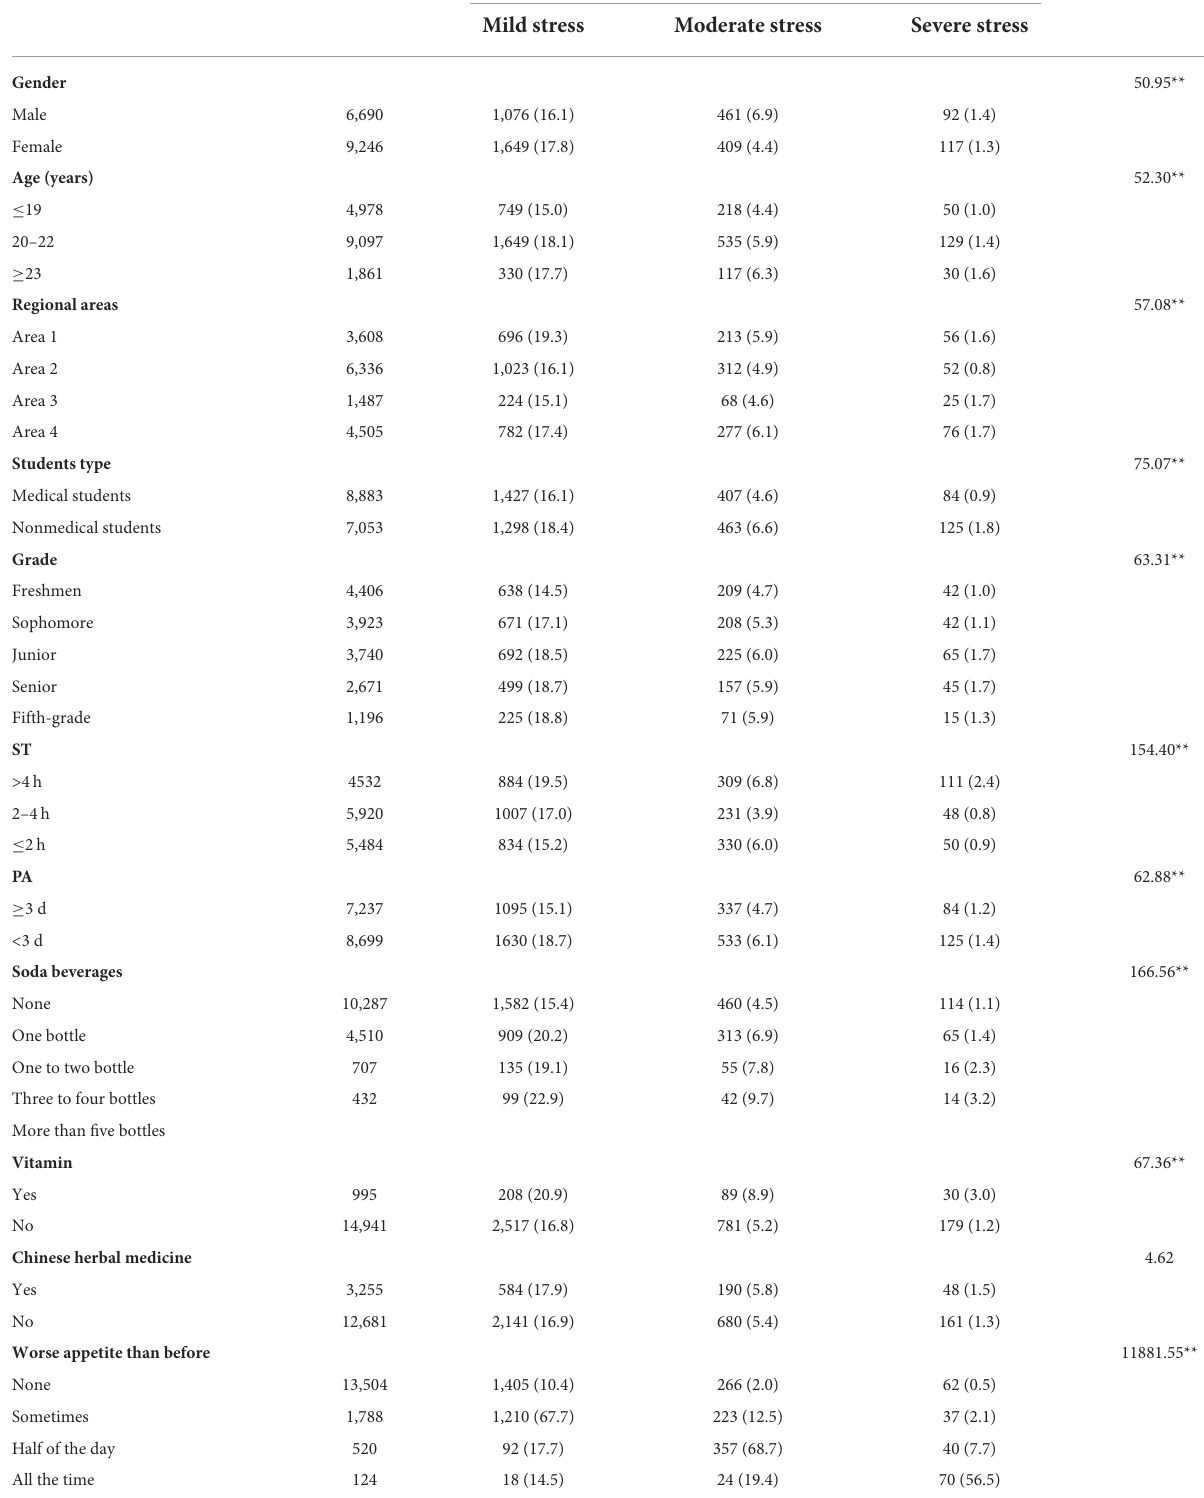
TABLE 2 The prevalence between health behaviors and anxiety among college students. Demographic